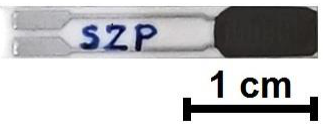
Figure 8. The thin nanocomposite layer after drop casting and drying on the sensor support with IDEs. The surface morphology of the SnSe 2 and Zn-metalloporphyrin powder precursors, and the final gas sensing nanocomposite, have been studied by scanning electron microscopy (SEM), and